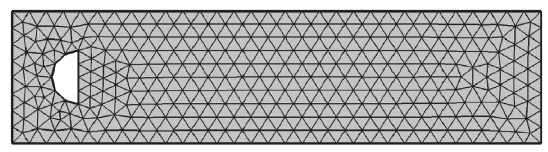
Figure 2: View of the coarse mesh of the